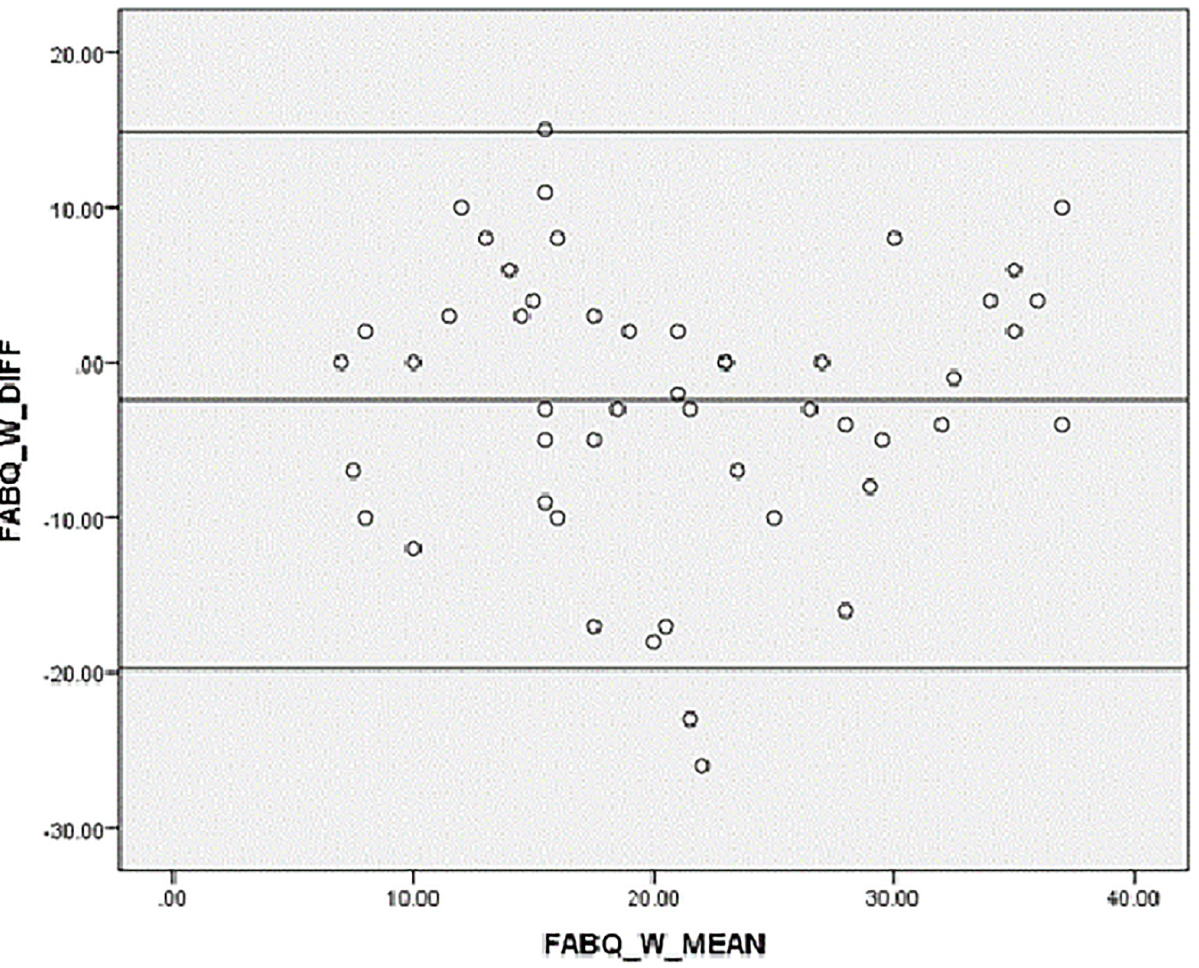
Fig 4. Bland-Altman plot for test-retest agreement of Igbo-FABQ (work). [upper limit: (+1.96 SD): 14.89; mean: -2.42 (-4.93, 0.09); SD: 8.83; lower limit: (-1.96 SD): -19.73].